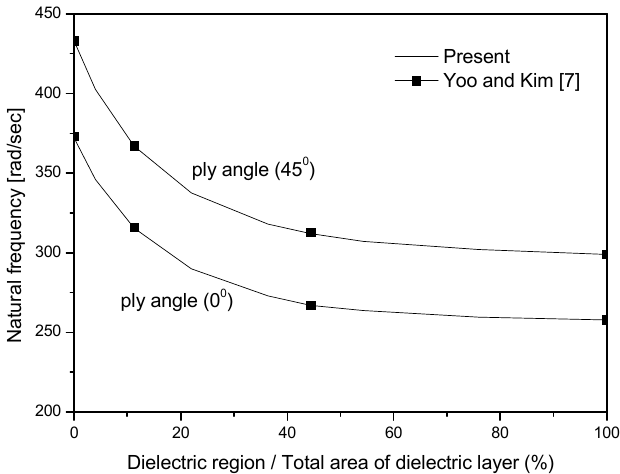
of the dielectric part (dielectric region/total area of dielectric layer). Then, the natural frequencies decrease as the dielectric portions increase, and the numerical results show good agreements with the data in Ref. [7].